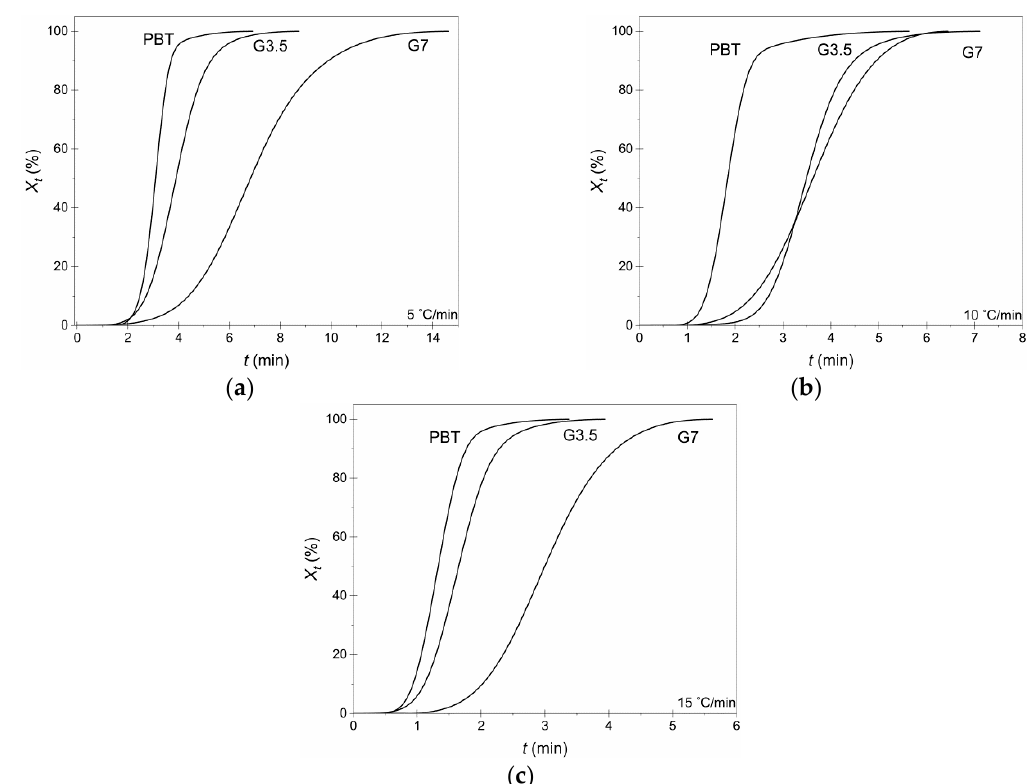
Figure 4. X t vs. t for pure PBT , G3.5 and G7 vitrimers (3 h at 180 °C) at each cooling rate: ( a ) 5 °C/min, ( b ) 10 °C/min and ( c ) 15 °C/min.